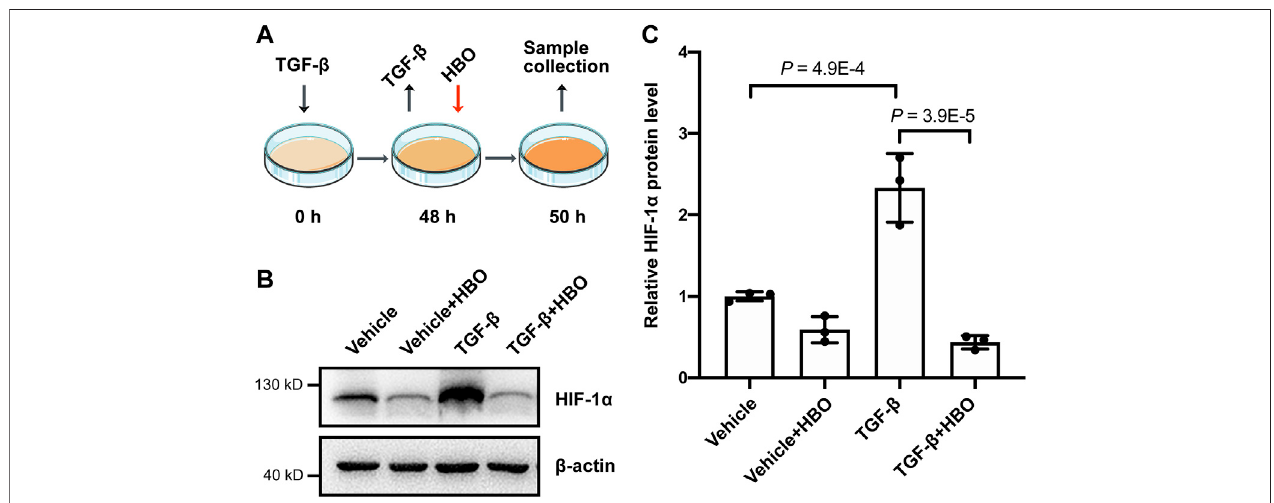
FIGURE 6 | Effects of HBO treatment on TGF- β – induced HIF-1 α expression in HFL1 cells. (A) Schematic diagram of the experimental procedure. In brief, TGF- β (5 ng/ml)wasaddedtoHFL1cellsfor48 htoinduce fi broblastactivation,afterwhichTGF- β wasremoved,andfollowed2.5 ATAHBOexposurefor90 minimmediately. SampleswerecollectedattheendofHBOexposure. (B) ProteinexpressionofHIF-1 α inHFL1cellswithindicatedtreatments. β -actinwasused asaloadingcontrol. (C) Fold change in the protein level of HIF-1 α in HFL1 cells with indicated treatments. β -actin – normalized protein levels in control cells (vehicle) were used to set the baseline value at unity. Data are mean ± s.d., with p values indicated. n (cid:2) 3 samples each group. Data were analyzed with one-way